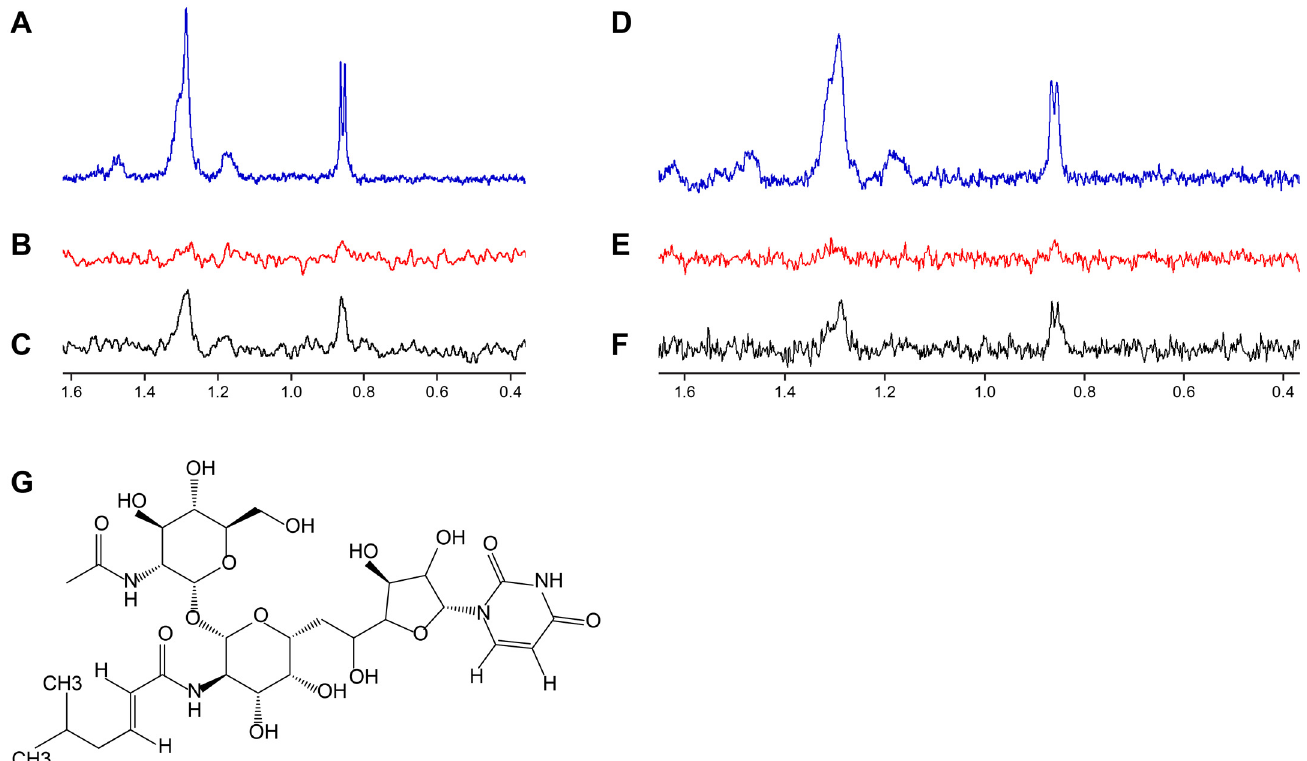
Fig 7. Biophysical studies demonstrate MnaA and Cap5P bind tunicamycin. (A, D) 600 MHz 1H NMR spectra of 15 μ M tunicamycin. (B, E) 1H NMR STD spectra of 15 μ M tunicamycin without 2-epimerase. (C) 1H NMR STD spectra of 15 μ M tunicamycin in presence of 5 μ M MnaA. (F) 1H NMR STD spectra of 15 μ M tunicamycin in presence of 5 μ M Cap5P. Saturation of the protein was achieved with a Gaussian pulse cascade resulting in a total saturation time of 3s. The protein resonances were saturated at 100 Hz and the off resonance was set to -120 ppm. Tunicamycin-specific peaks in NMR STD spectra were only obtained in the presence of MnaA or Cap5P. (G) Structure of tunicamycin.